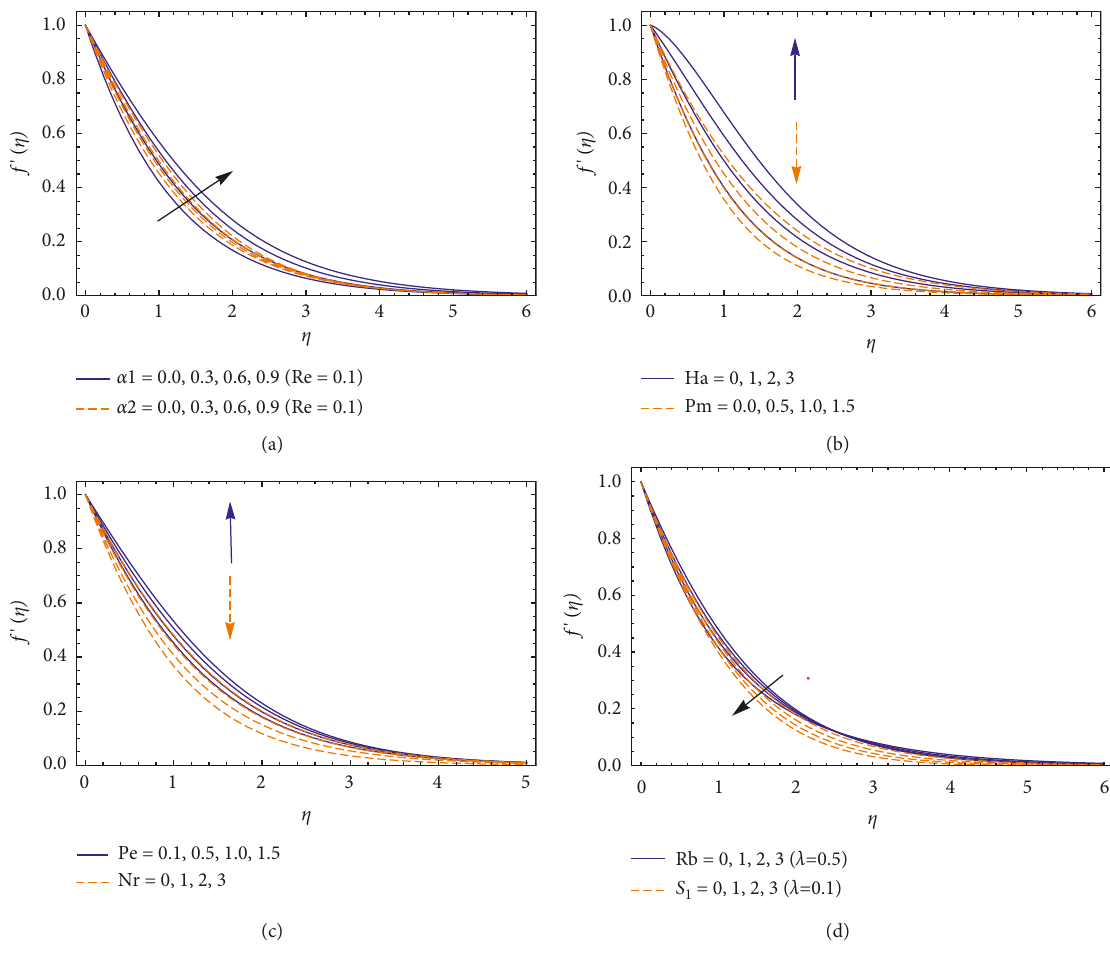
Figure 2: Velocity profile for different values of α